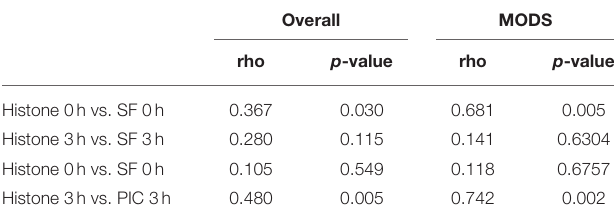
TABLE 2 | Correlation between histones and coagulofibrinolytic markers. Overall MODS rho p -value rho p -value